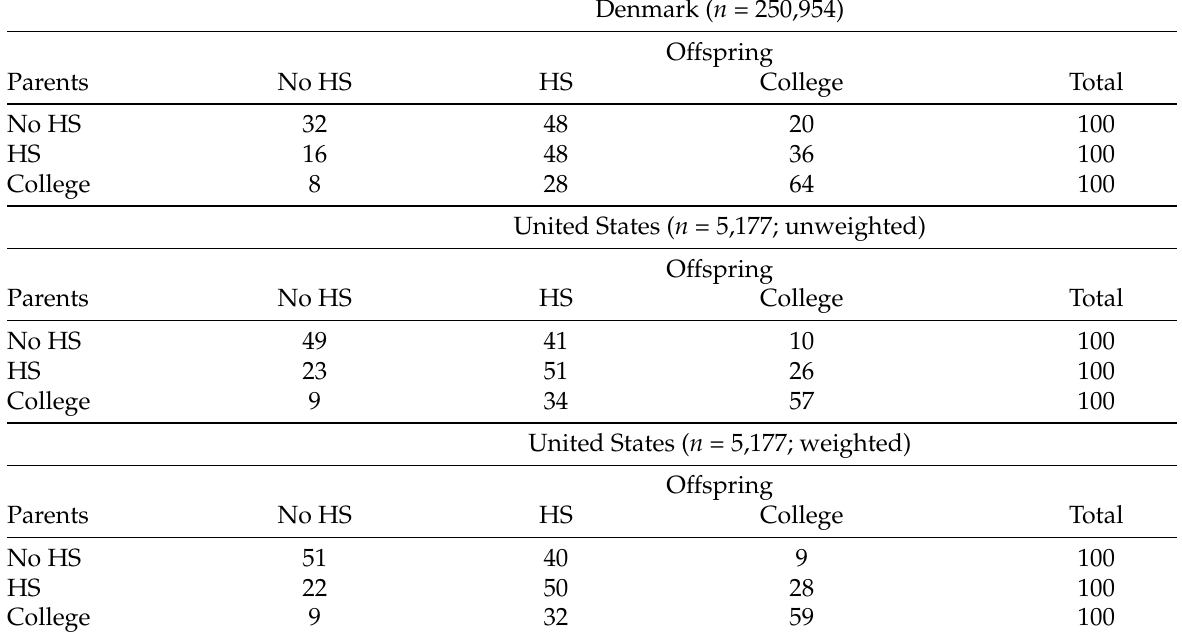
Table 1: Children’s degree status (2013) by parents’ highest